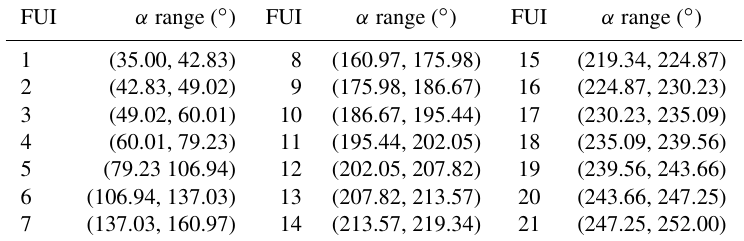
Table 2. The 21-class FUI indices and the corresponding range of hue angle α (Wang et al., 2018; Chen et al., 2021). FUI α range ( ◦ )